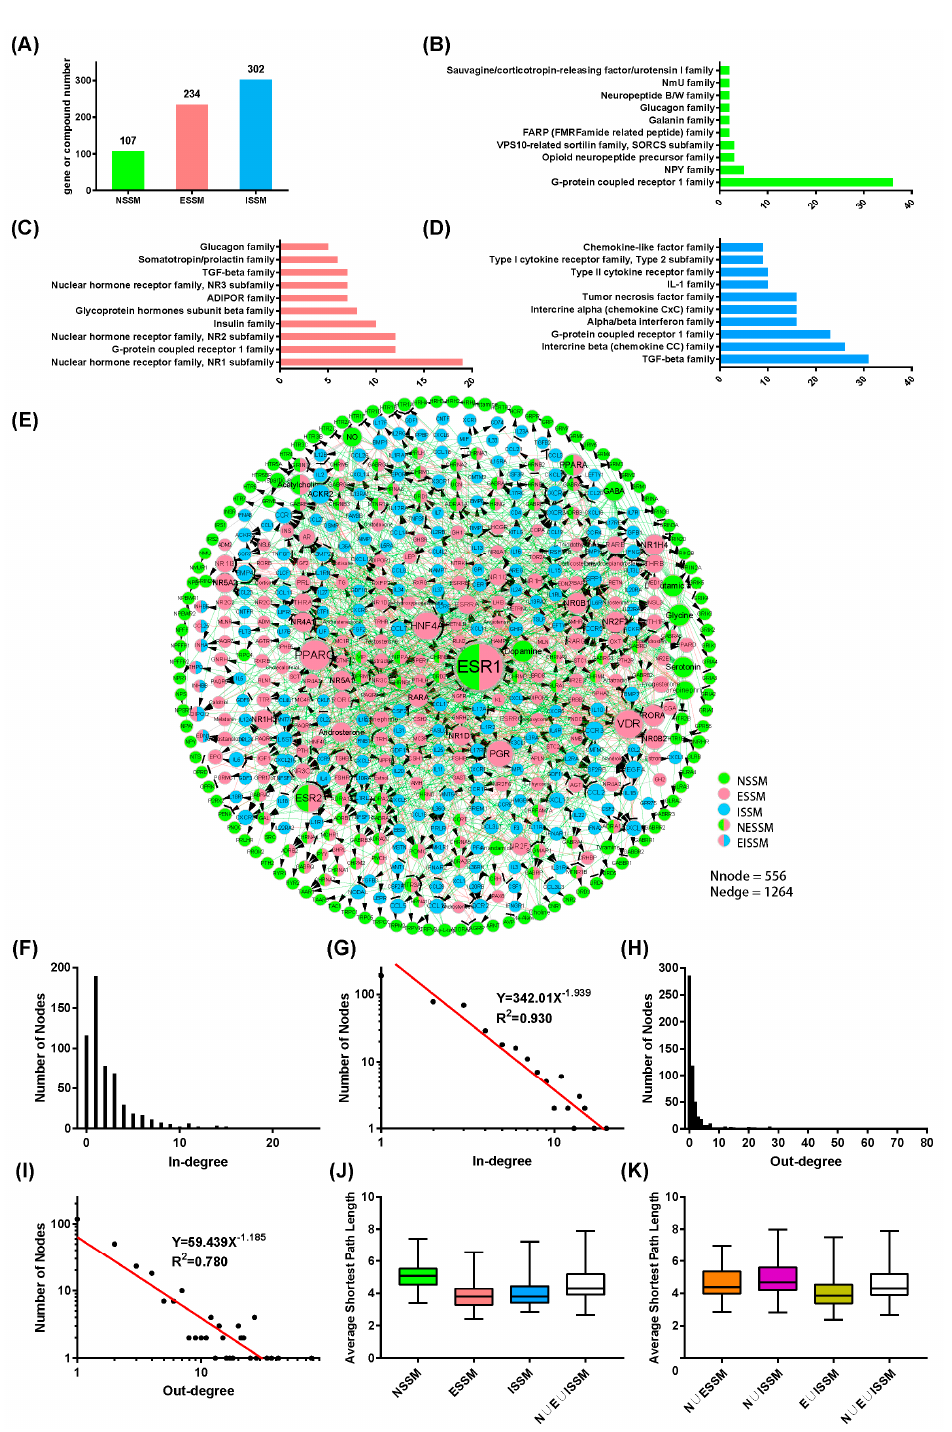
Figure 1. The raw data analysis for the dataset of neuroendocrine immunomodulation (NIM) signaling molecules and the core network of NIM signaling molecules. ( A ) The number distribution of the